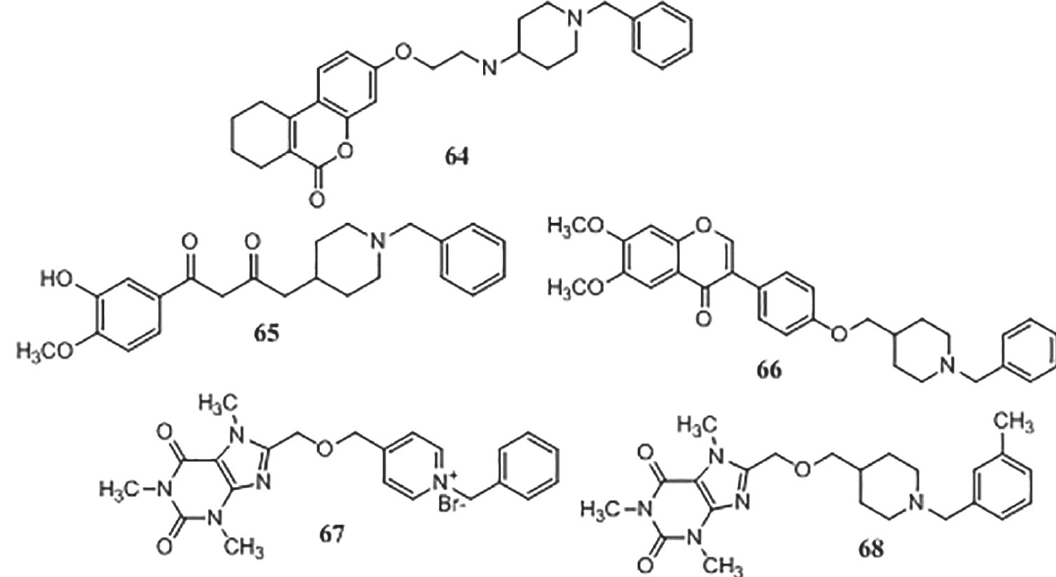
FIGURE 9 - Donepezil hybrids molecules with natural